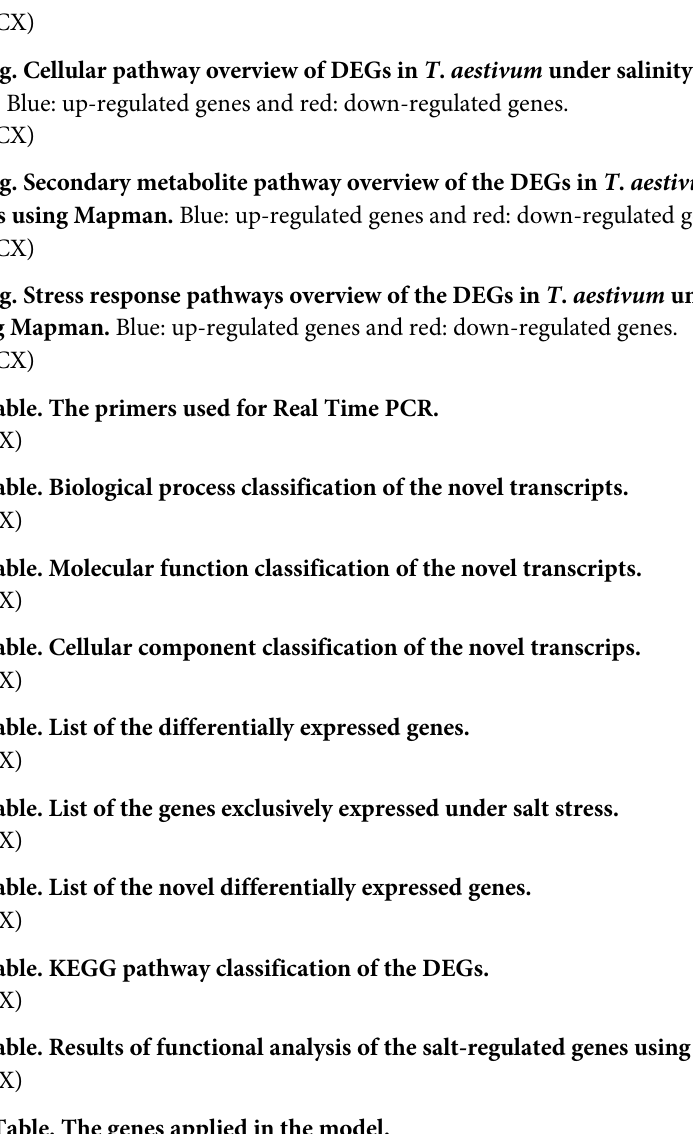
S2 Fig. Comparison of means for changes in Na+ content (a), K+ content (b) and K+/Na + ratio (c) in the roots of Arg and Moghan3 under the normal and salinity treated condi- tions at the probability level of 5%. S3 Fig. Survey of DEGs observed between the control and salt treated samples (cut off p- value: 0.01). (a) Out of 4290 DEGs, 110 and 98 genes were exclusively expressed under the salt stress (STL) and control (CL) conditions, respectively (b) Fold change distribution of 4082 DEGs present in both normal and salt treated samples. S4 Fig. (a) Annotation statistics of the novel DEGs. (b) GO classification of the novel DEGs under salt stress. S5 Fig. Cellular pathway overview of DEGs in T . aestivum under salinity stress using Map- man. Blue: up-regulated genes and red: down-regulated genes. (DOCX) S6 Fig. Secondary metabolite pathway overview of the DEGs in T . aestivum under salinity stress using Mapman. Blue: up-regulated genes and red: down-regulated genes. (DOCX) S7 Fig. Stress response pathways overview of the DEGs in T . aestivum under salinity stress using Mapman. Blue: up-regulated genes and red: down-regulated genes. (DOCX) S1 Table. The primers used for Real Time PCR. S2 Table. Biological process classification of the novel transcripts. (XLSX) S3 Table. Molecular function classification of the novel transcripts. (XLSX) S4 Table. Cellular component classification of the novel transcrips. (XLSX) S5 Table. List of the differentially expressed genes. (XLSX) S6 Table. List of the genes exclusively expressed under salt stress. (XLSX) S7 Table. List of the novel differentially expressed genes. (XLSX) S8 Table. KEGG pathway classification of the DEGs. (XLSX) S9 Table. Results of functional analysis of the salt-regulated genes using Mapman. (XLSX) S10 Table. The genes applied in the model.